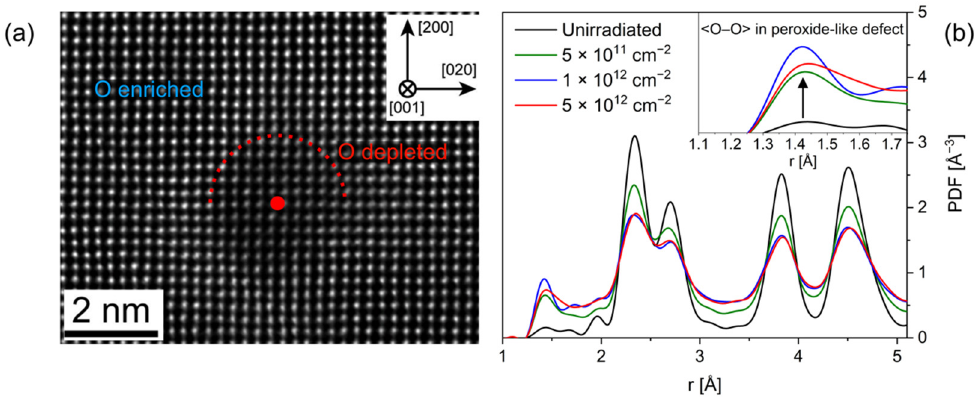
Figure 4. ( a ) HRTEM image of a single 200 MeV 132 Xe ion track in CeO 2 with a core-shell damage morphology, consisting of an oxygen depleted core (red) and oxygen interstitial rich shell (blue). ( b ) Neutron pair distribution functions (PDFs) of CeO 2 before and after irradiation with 2000 MeV 197 Au ions up to 5 × 10 12 ions/cm 2 . A loss of structural order is indicated by the symmetric peak broadening and the decrease in the intensity of correlation peaks. A structural feature at ~1.45 Å is observed after irradiation (inset) indicative of the formation of peroxide-like defects. Adapted from ( a ) Takaki et al. [42] and ( b ) Palomares et al. [50].